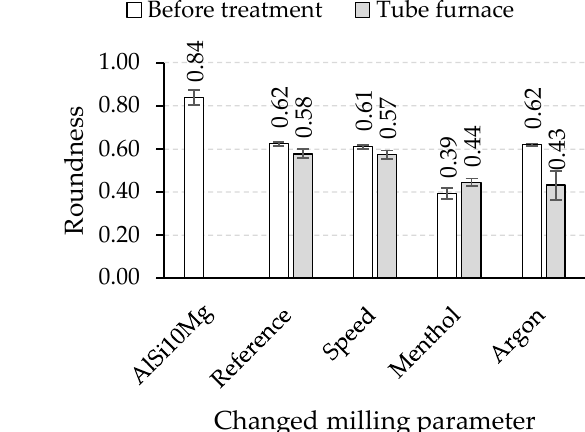
Figure 10. Results of ( a ) mean particle area and ( b ) roundness after a thermal post-treatment in a tube furnace at 515 °C for 3.5 h.